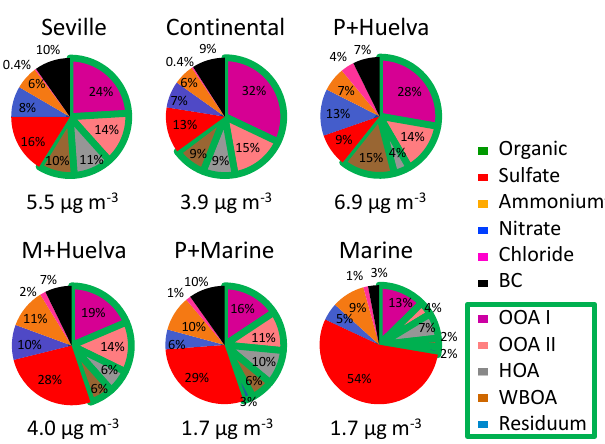
Fig. 5. Pie charts of the submicron aerosol composition of the PM 1 for each air mass type consisting of organics (green), sulfate (red), ammonium (orange), nitrate (blue), chloride (purple) and black carbon (black). Organic material was further separated into OOA I (dark purple), OOA II (salmon), HOA (grey) and WBOA (brown) using PMF. The residuum (light blue) cannot be associated with any of these sources or